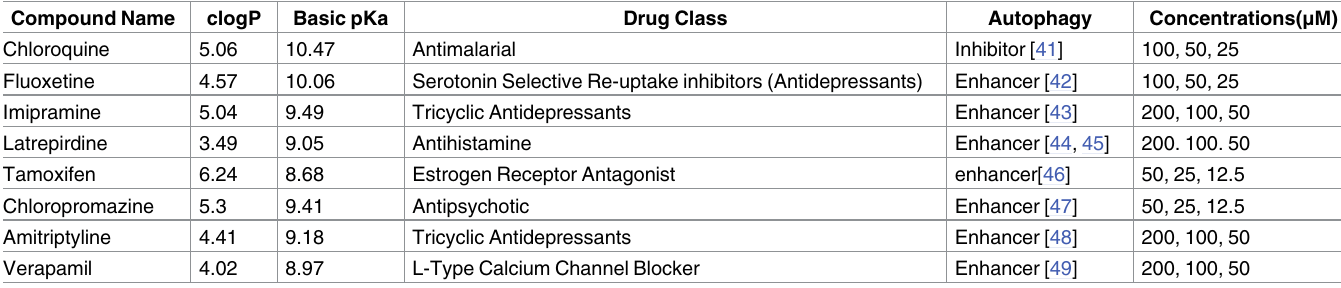
Table 1. Physicochemical properties, impact on autophagy and concentrations used in the